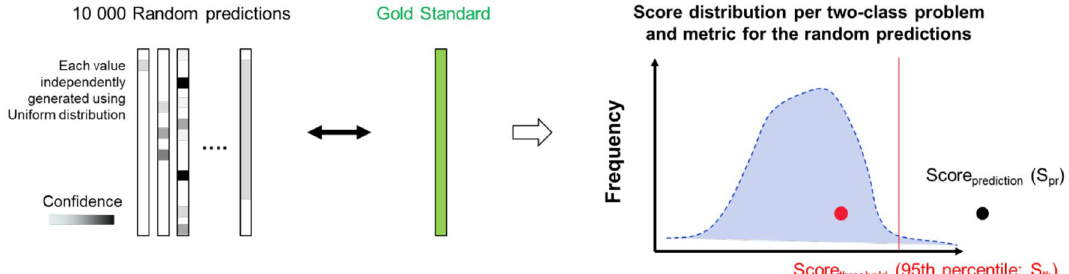
Figure 9. Overview of prediction randomness